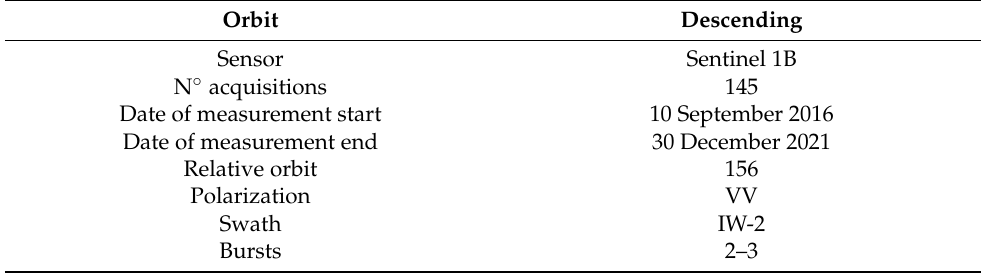
Table 1. Features of the Sentinel 1